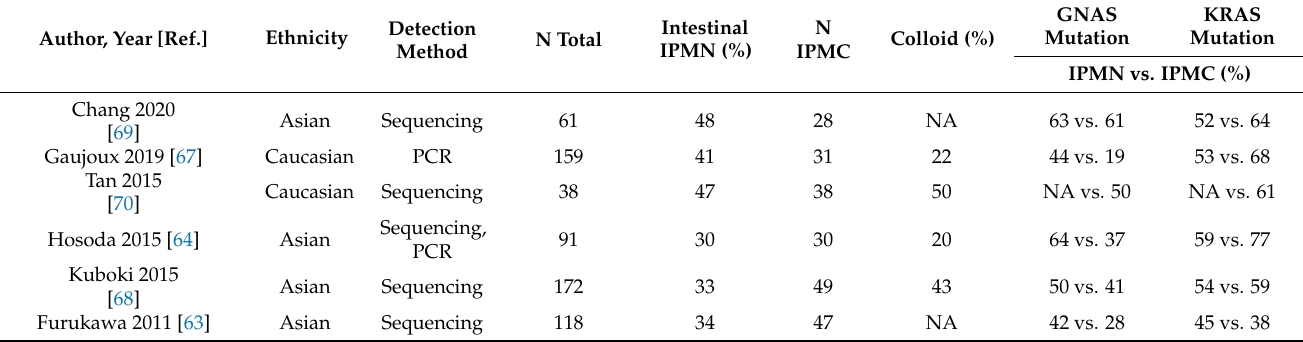
Table 3. Studies evaluating GNAS and KRAS mutations in IPMC +/- IPMN (tissue analysis, >10 IPMC cases). Author, Year